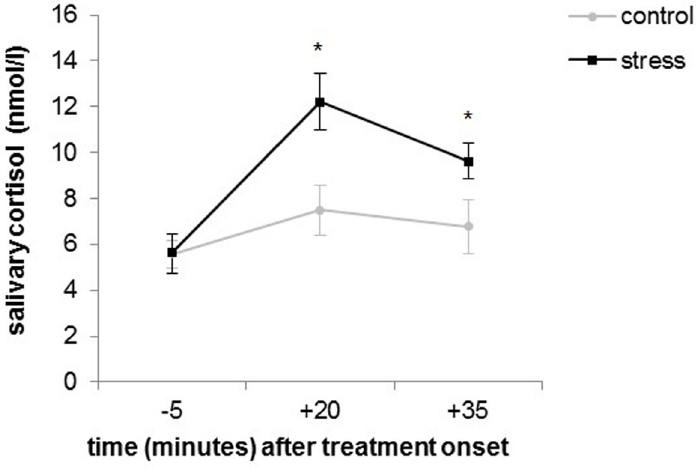
Fig 2. Mean salivary cortisol concentrations of participants from the control and stress condition throughout the experiment. Error bars represent standard errors.